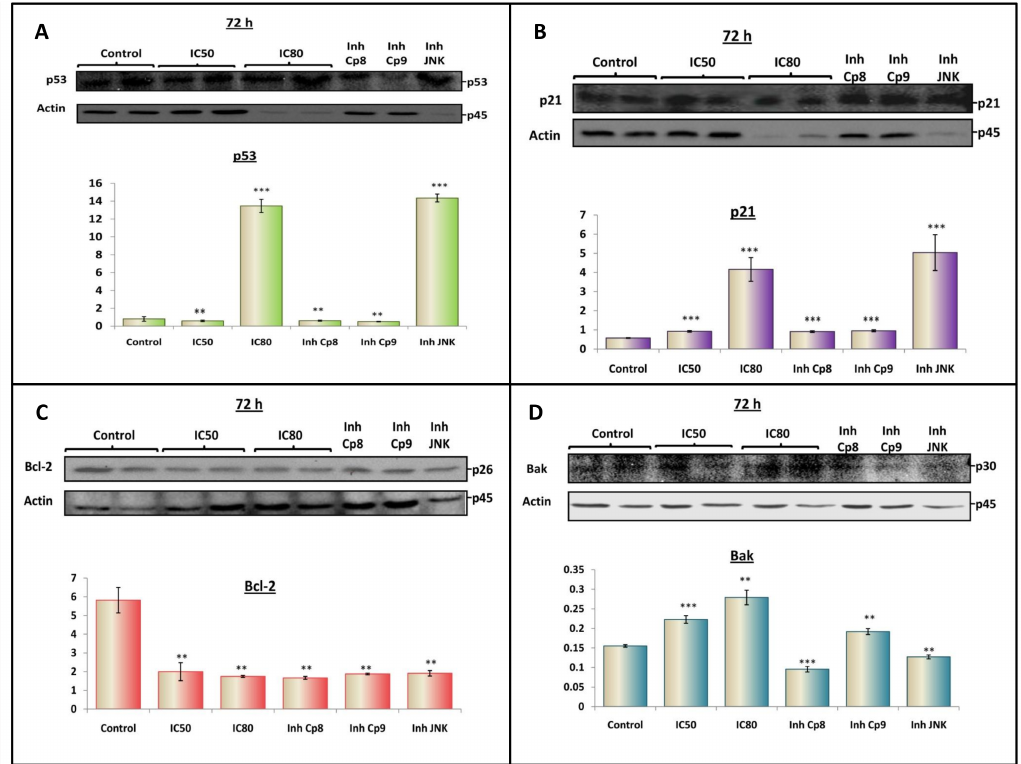
Figure 7. Western blot analysis of the protein levels of p53 ( A ), p21 ( B ), Bcl-2 ( C ), and Bak ( D ). HepG2 cells were treated with OADP at IC 50 and IC 80 concentrations. ‘Inh Cp8’, ‘Inh Cp9’ and ‘Inh JNK’ correspond to the combined treatment with caspase-8 inhibitor, the caspase-9 inhibitor, and the JNK inhibitor, respectively. Protein expression levels are expressed as units of arbitrary intensity for each band, compared to the units of arbitrary intensity for the actin band. Values represent the mean at least three separate experiments. Key: (**) p < 0.01 and (***) p < 0.001, with respect to the untreated control